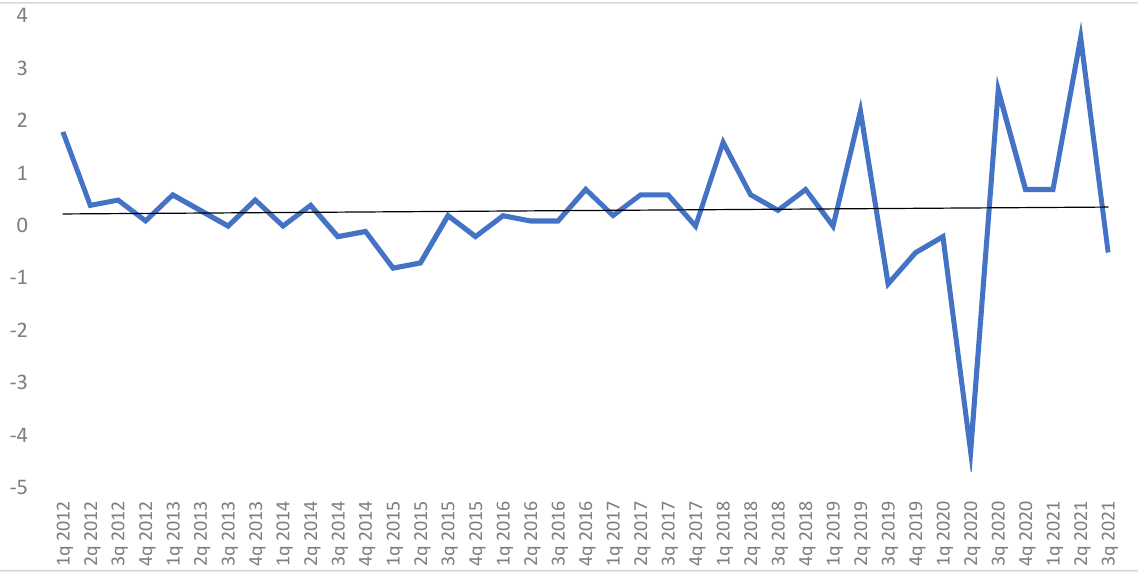
Table 1. Investment dynamics in fixed assets in the Russian Federation (2010–2020). Year Investment Dynamics in Fixed Assets, in % 2010